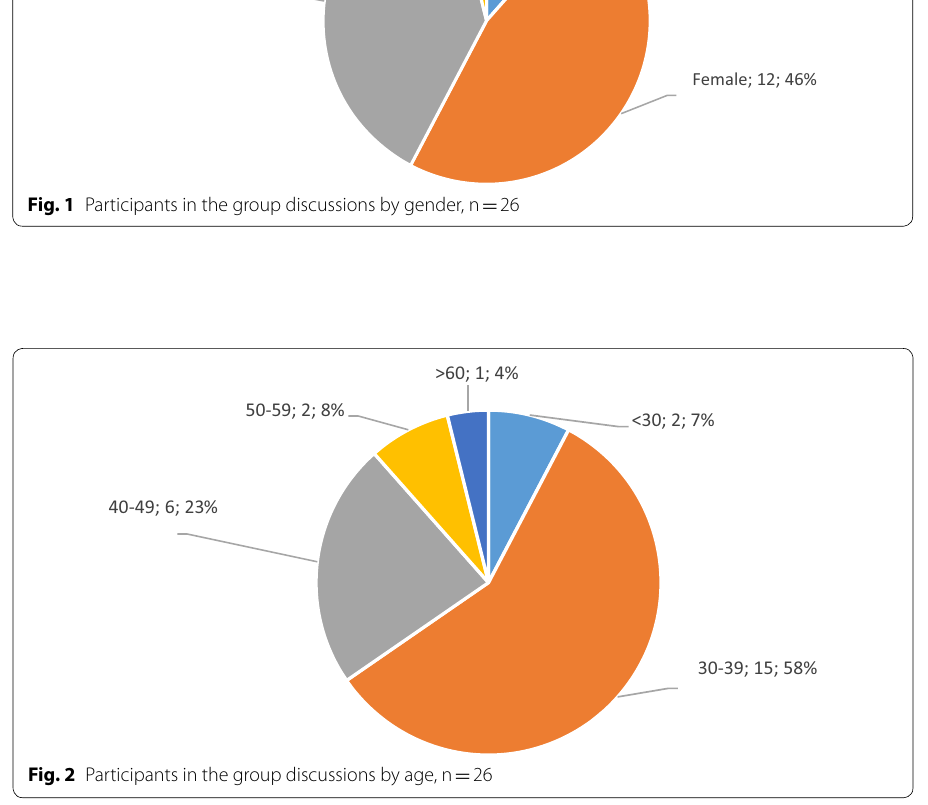
Fig. 2 Participants in the group discussions by age, n